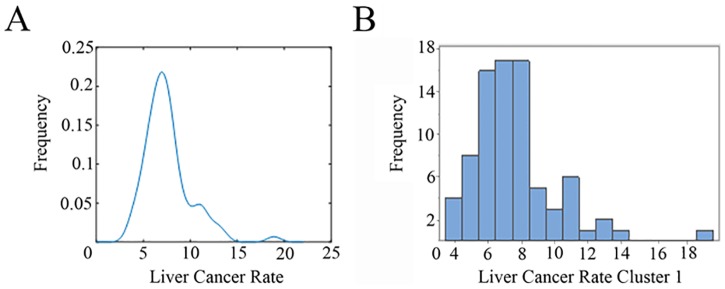
(A) Kernel estimator and (B) histogram for liver cancer rate in cluster 1.